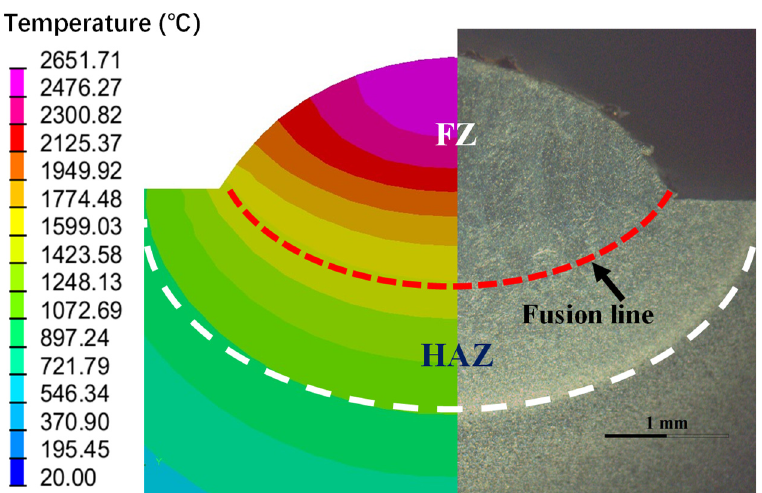
Figure 7. Comparison diagram of simulated and experimental profile results of deposition layer.